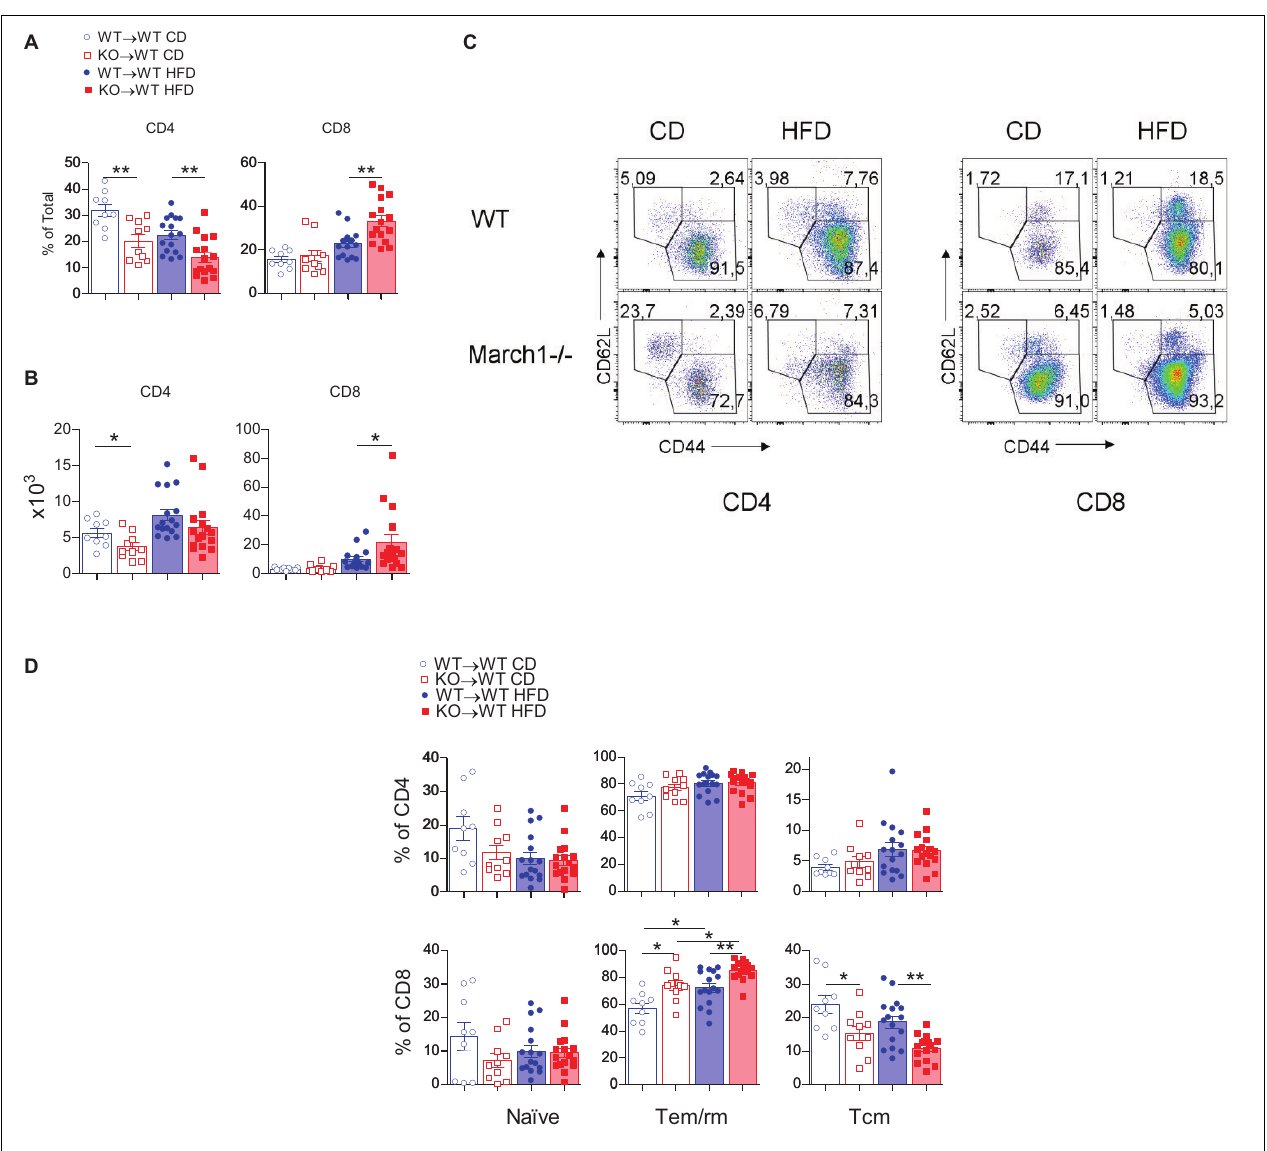
FIGURE 3 | Absence of March1 increases CD8 T cell infiltration and modifies the fate of WAT memory cells. WAT from obese and lean WT → WT and KO → WT mice was analyzed by flow cytometry for T cells. Percentage (A) and absolute number (B) of CD4 + and CD8 + T cells. Representative dot plots of naive, Tem/rm and Tcm cells (C) . Proportions of naive, Tem/rm and Tcm cells (D) . ∗ P < 0.05 and ∗∗ P <